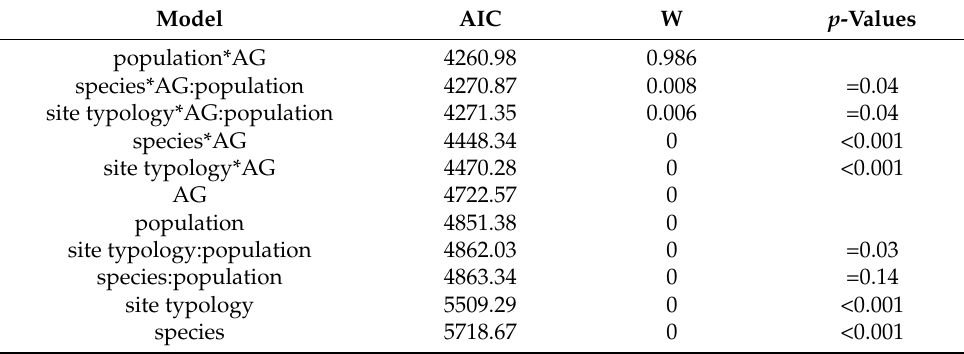
Table 3. Model ranking of candidate models used to analyse the multivariate dependence of body features (see text for details) of salamanders based on the species ( Salamandrina perspicillata or S. terdigitata ), the type of breeding site (brook or lentic water), their population (five populations) and the individual axilla-groin distance (AG; “*” denote the use of AG as covariate). Species, site type and axilla-groin distance were been used as fixed factors, population as random factor (when together, the random factor is nested in the fixed one). AICc is the Akaike’s information criterion for the small sample size, w is the model weight. p -value refers to the categorical fixed factor species or site typology for the given MAN(C)OVA